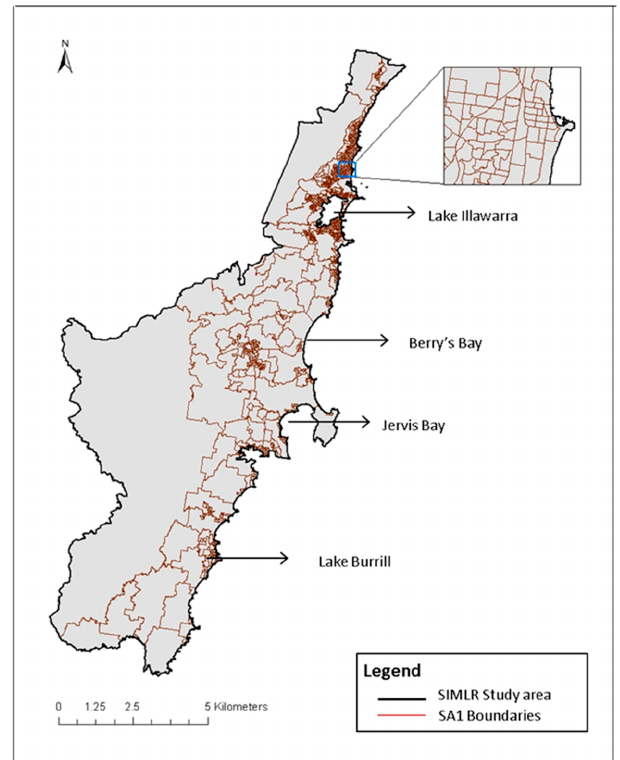
Figure 1. Map of the Illawarra-Shoalhaven region of NSW, Australia, showing SA1 areas and major